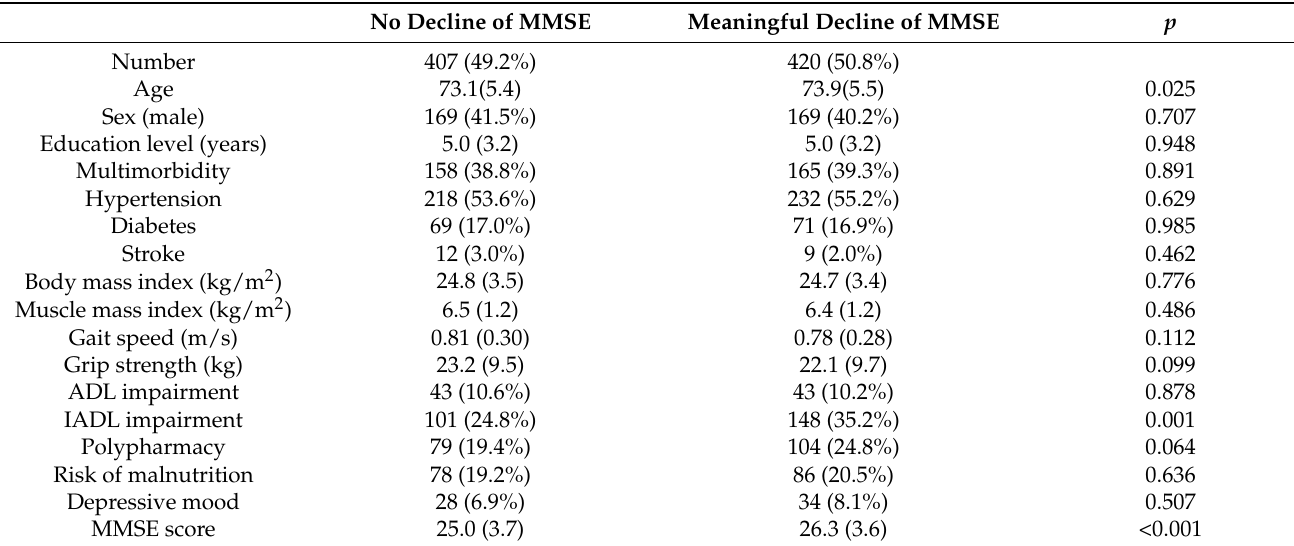
Table 1. Demographic characteristics of the